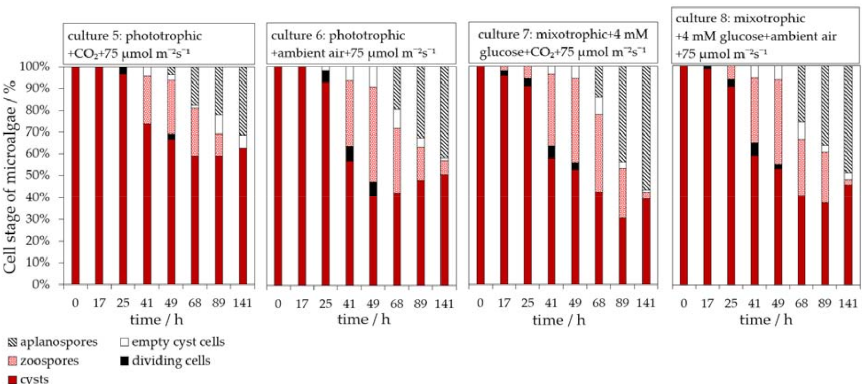
Figure 5. Relative distribution of the cell stages of H. pluvialis at different points in time after the start of germination for culture 5 (phototrophic + CO 2 + 75 µ mol m − 2 s − 1 ) and culture 6 (phototrophic + ambient air + 75 µ mol m − 2 s − 1 ), and culture 7 (mixotrophic + 4 mM glucose + CO 2 + 75 µ mol m − 2 s − 1 ) and culture 8 (mixotrophic + 4 mM glucose + ambient air + 75 µ mol m − 2 s − 1